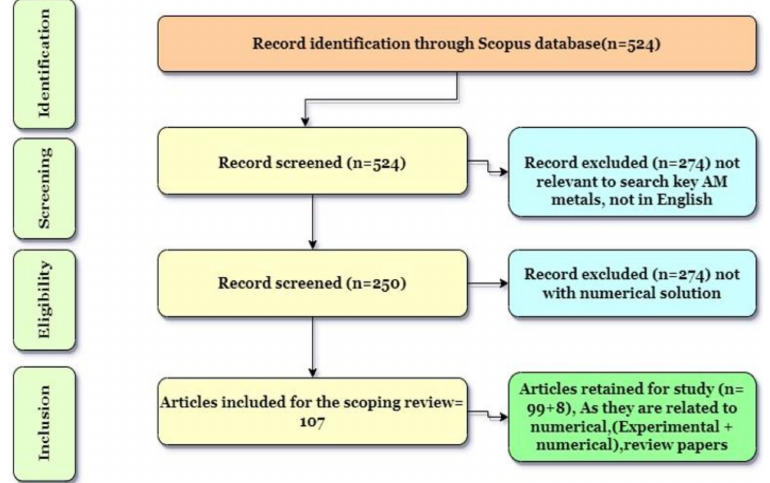
Figure 1. Source selection process from literature